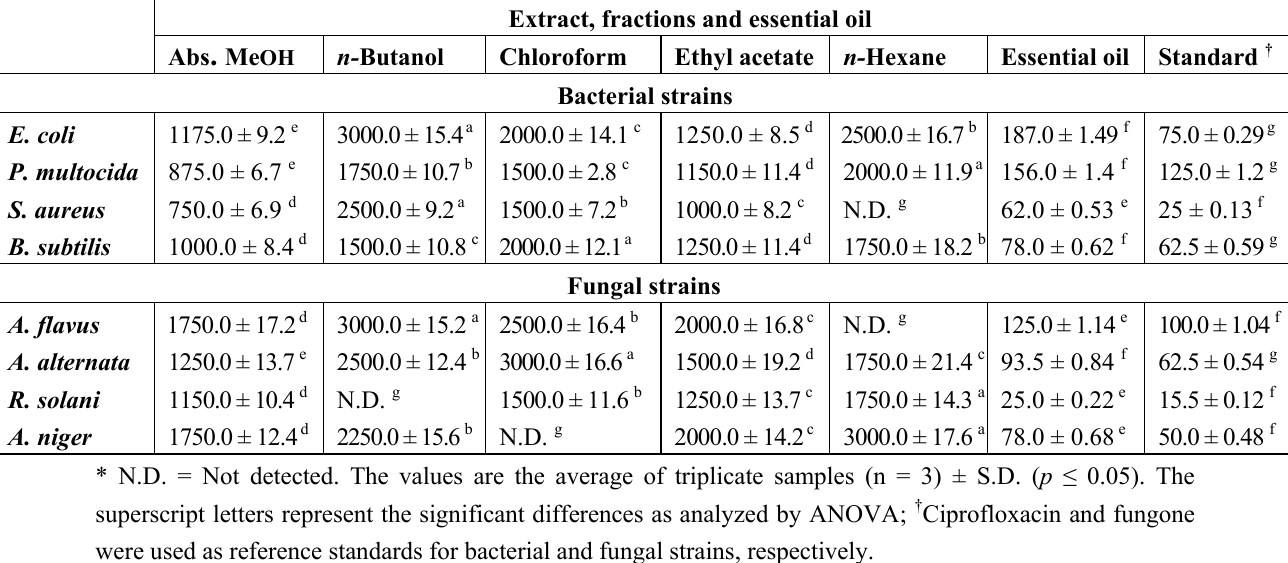
Table 4. Antimicrobial activity in terms of minimum inhibitory concentration (MIC) in µg/mL by M. goodenifolius plant against selected bacterial and fungal